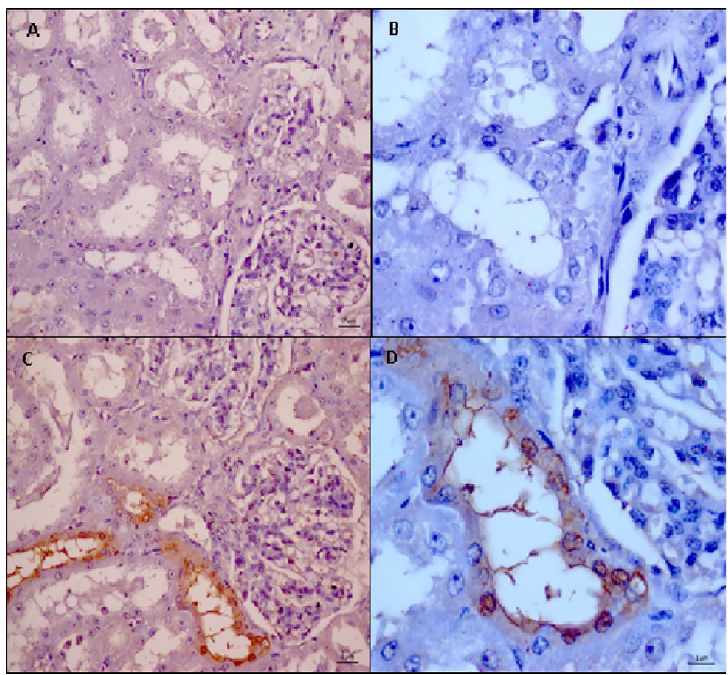
Fig 1. Photomicrography of renal parenchyma of sheep. ( A) and (B) negative control of the reaction. Note absence of immunostaining in the epithelium and tubular lumen (magnification of 400x and 1000x respectively); ( C) and ( D) . Positively labeled sections by anti-LipL32: ( C) Immunohistochemistry (IHC). Positive immunoprecipitation of Leptospira antigen on the epithelium and tubular lumen (magnification of 400x); ( D) Immunostaining in tubular epithelial cells and brown-marked structures corresponding to the Leptospira antigen adhered to the tubular lumen (1000x